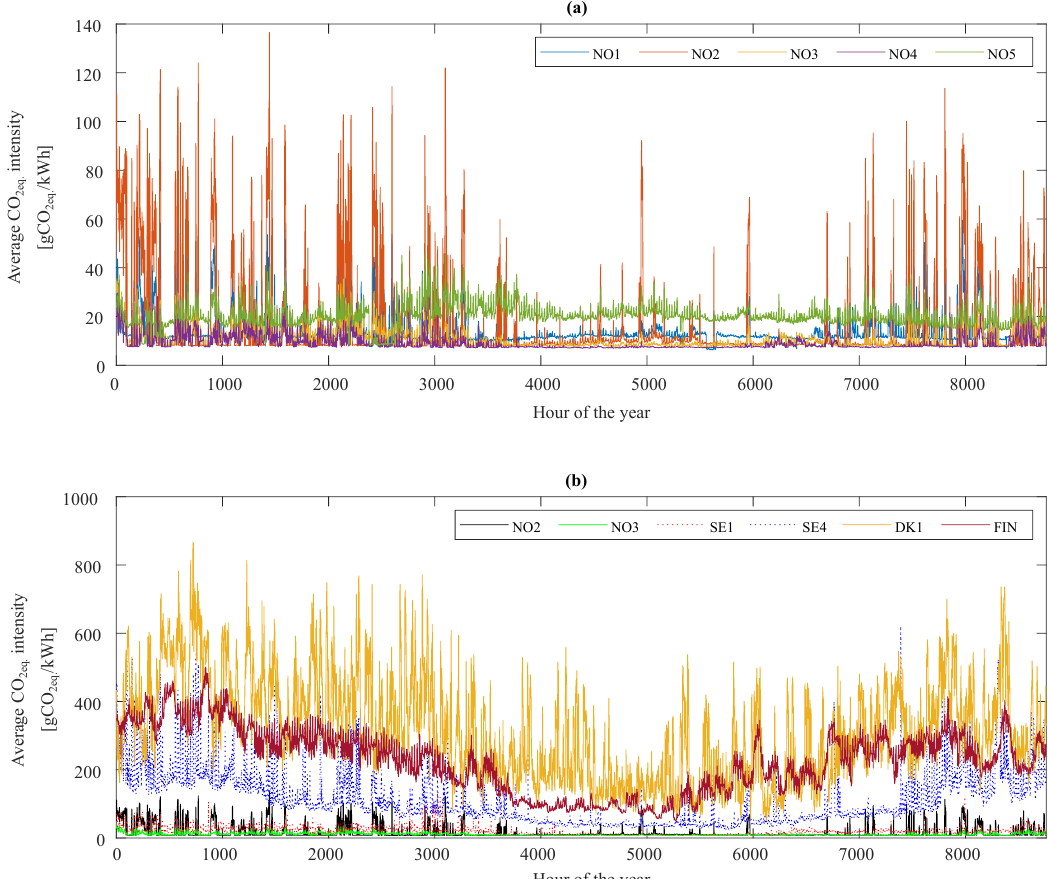
Figure 2. Hourly average CO 2eq. intensity of the electricity mix for ( a ) the Norwegian bidding zones and ( b ) for several Scandinavian bidding